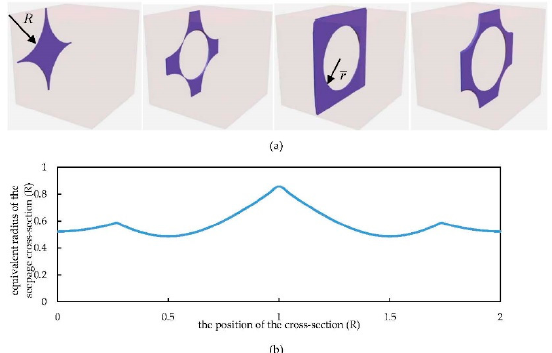
Figure 4. The changing process of the seepage cross-sectional area in a percolation microelement. ( a ) The continuously changing cross section represents the pore space of the blue area in Figure 3b. ( b ) The equivalent radius at any position x in a percolation microelement.